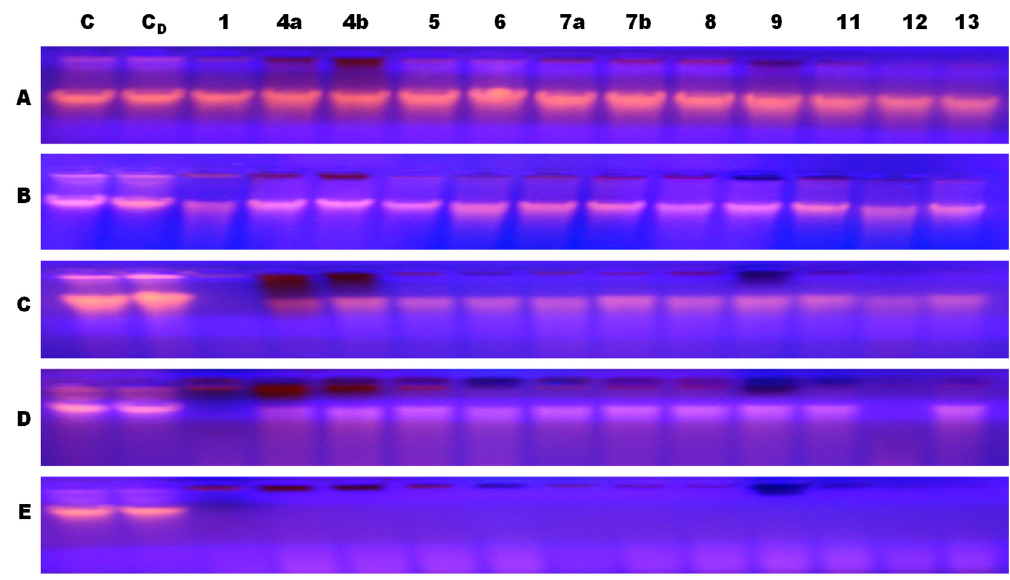
Figure 1. A figure showing the degradation effect of 2 ( A ), 4 ( B ), 6 ( C ), 8 ( D ), and 10 ( E ) µM of compounds ( 1 , 4a , 4b , 5 , 6 , 7a , 7b , 8 , 9 , 11 , 12 , and 13 ) (Lanes 3–14) on the genomic DNA isolated